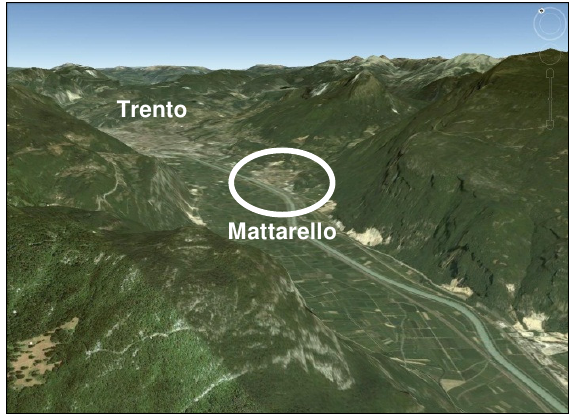
Figure 1 – Aerial view (Google Earth) of the Adige valley in the Alps, with the location of the test site: Mattarello, Trento, Italy